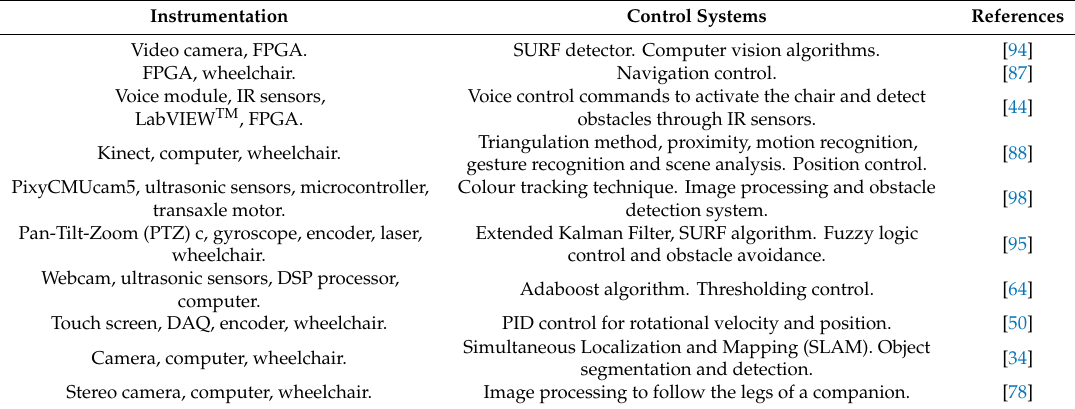
Table 9. Instrumentation and control strategies for artificial